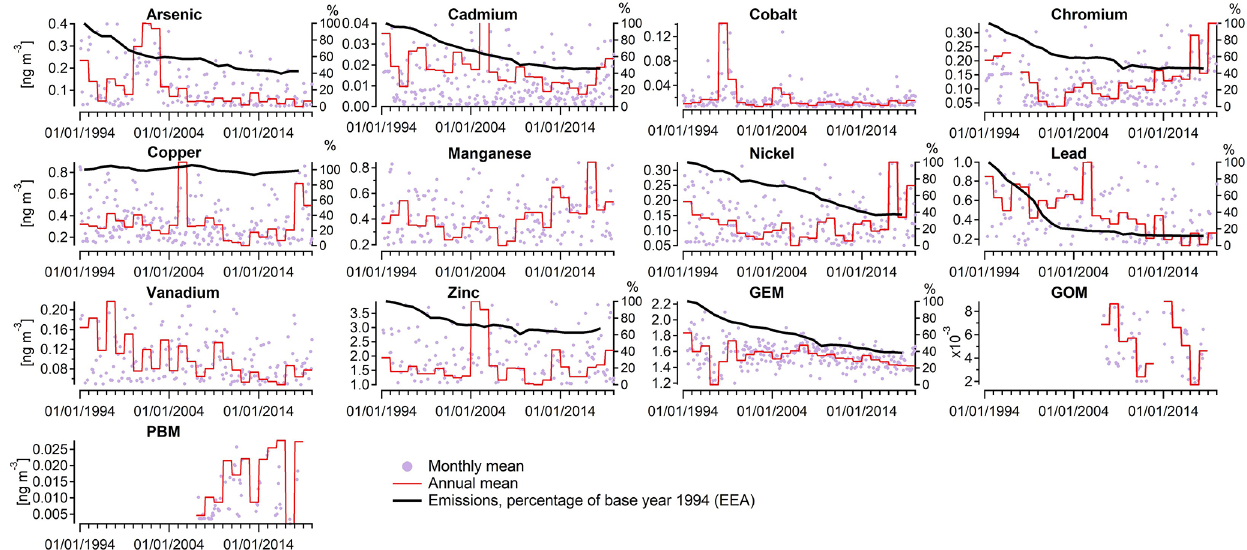
Figure 19. Monthly (violet) and annual (red) mean concentrations of heavy metals, gaseous elemental mercury (GEM), gaseous organic mercury (GOM), and particle-bound mercury (PBM) at the Zeppelin Observatory. Estimated emissions as a percentage of the base year 1994 according to the European Environment Agency (EEA, black) are shown where available (with the scale on the right axes). Monthly and annual means calculated only where data coverage is 75% of the total month or year,